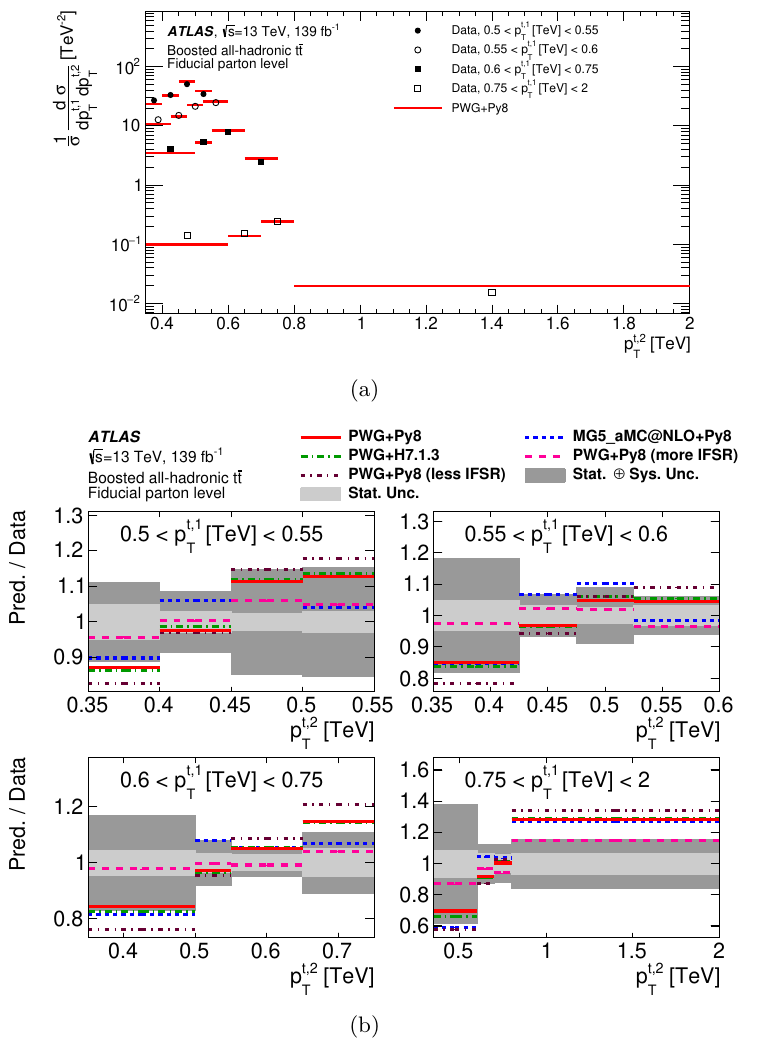
Figure 25 . (a) Normalized parton-level fiducial phase-space double-differential cross-sections as a function of the transverse momenta of the leading and second-leading top quarks, compared with the Powheg+Pythia 8 calculation. Data points are placed at the centre of each bin and the Powheg+Pythia 8 calculation is indicated by solid lines. (b) The ratios of various MC calculations to the normalized parton-level fiducial phase-space differential cross-sections. The dark and light grey bands indicate the total uncertainty and the statistical uncertainty, respectively, of the data in each